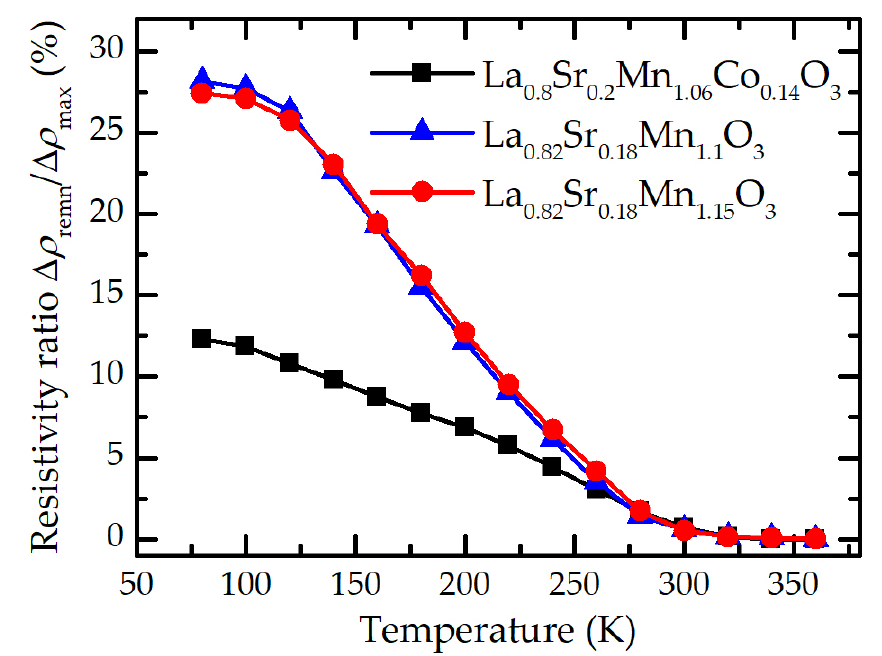
Figure 5. Absolute value of remnant resistivity normalized to the maximal resistivity change (at B = 10 T).